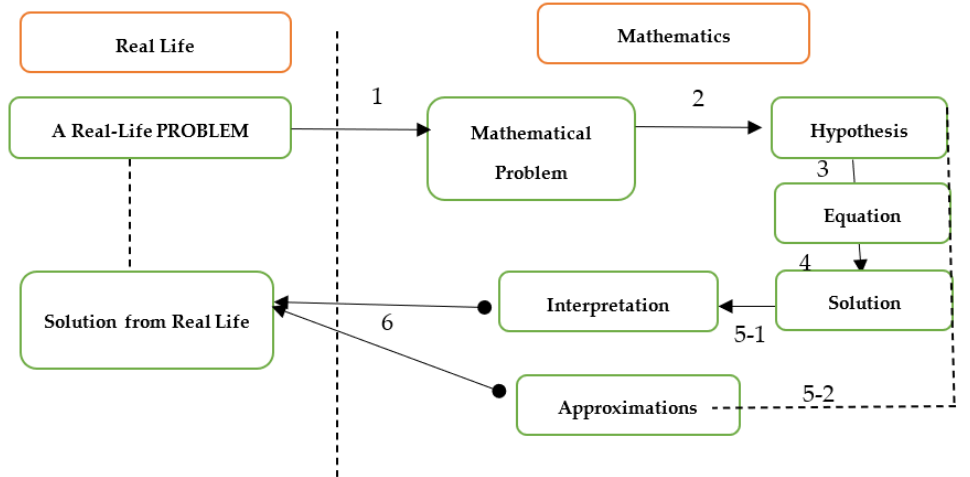
Figure 1. Ang’s Model